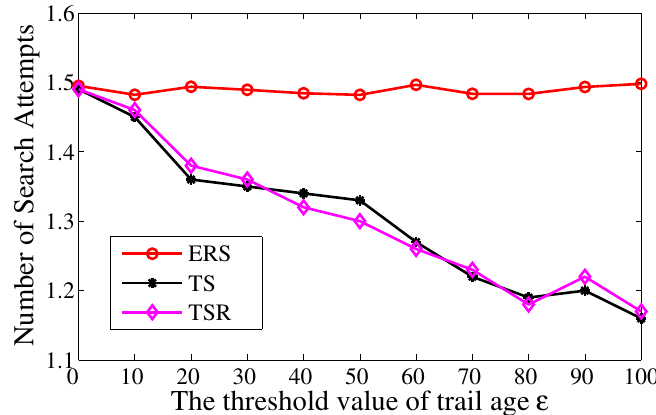
Figure 9. The average times of search attempts over the threshold value of trail age ε .